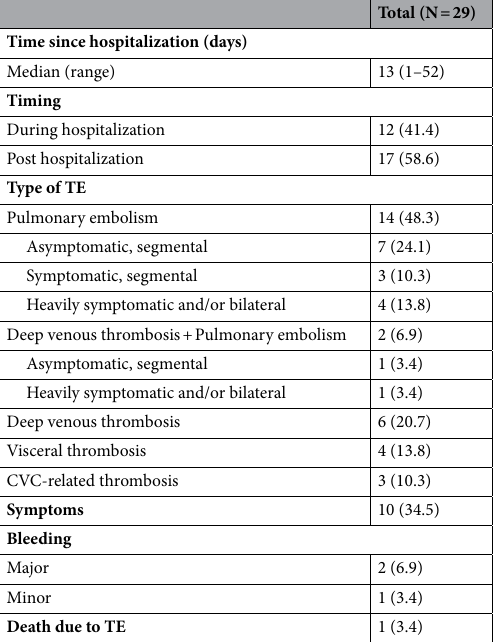
Table 2. Detailed characteristics of thromboembolic events. CVC central venous catheter, TE thromboembolic